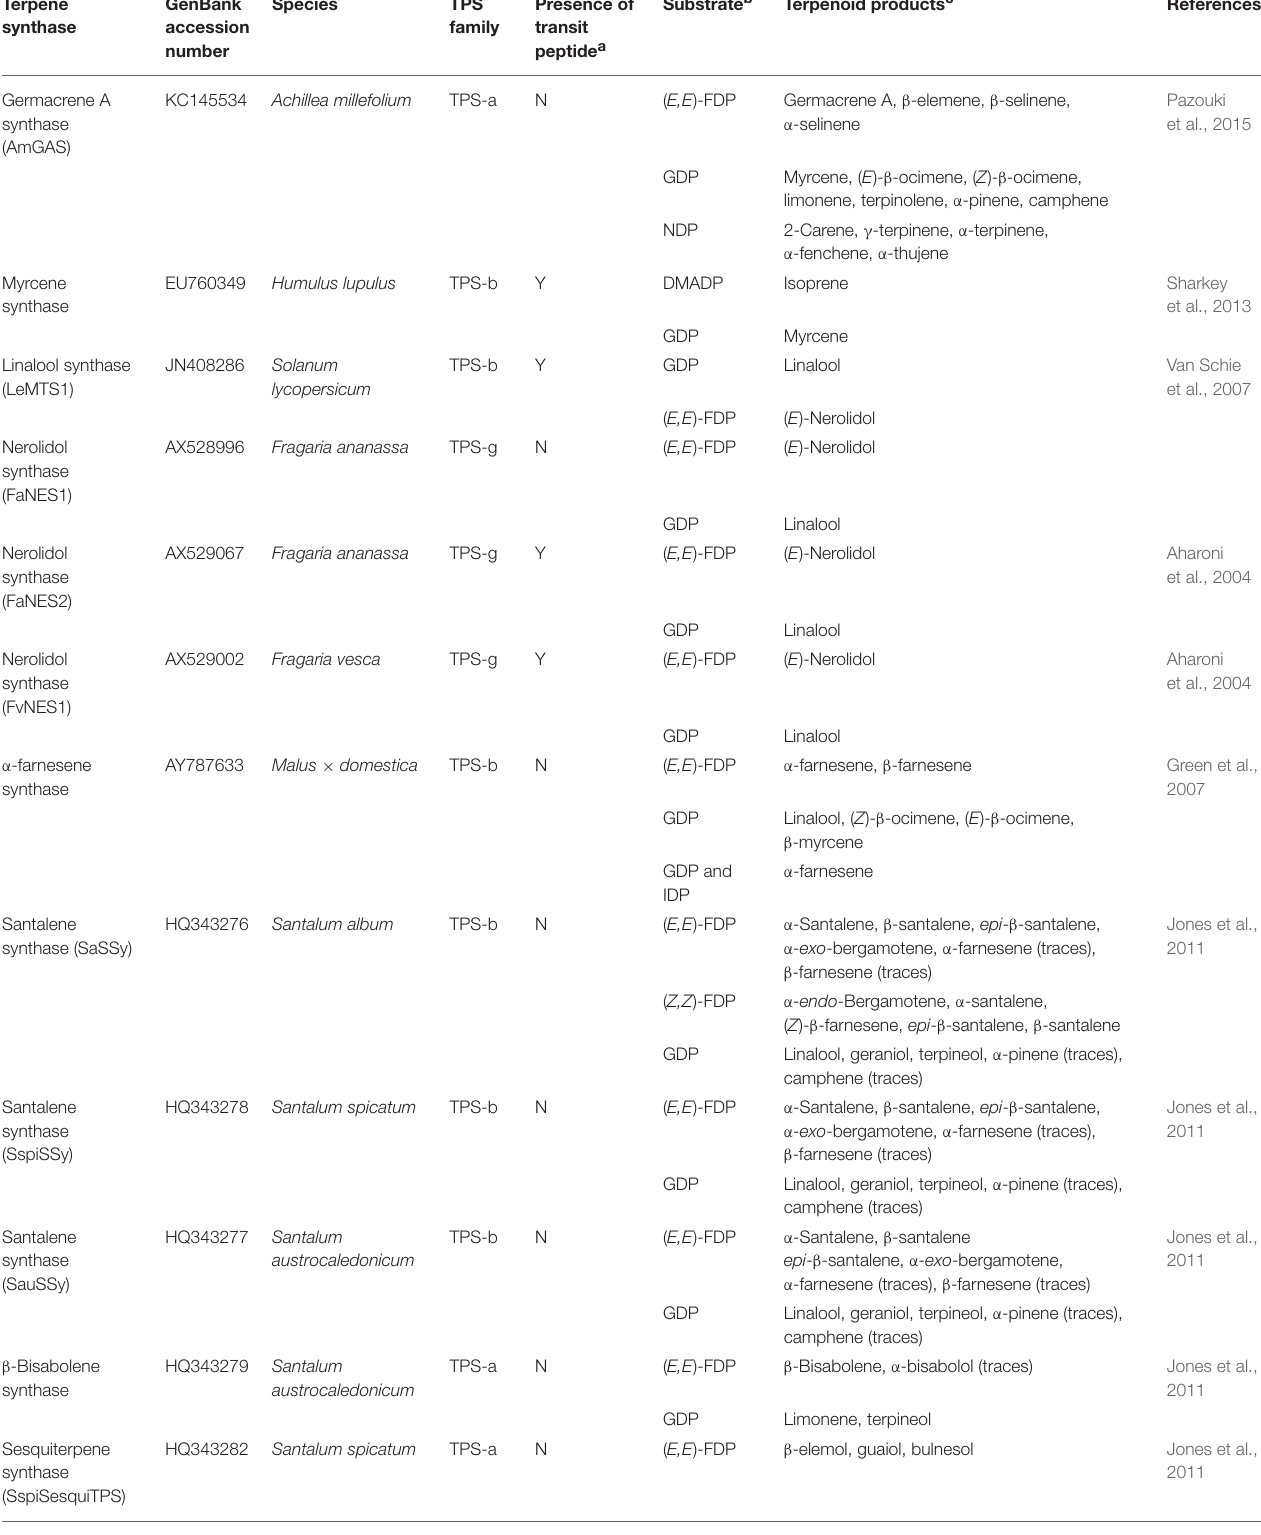
TABLE 1 | Overview of plant terpene synthases with confirmed multi-substrate activity. Terpene